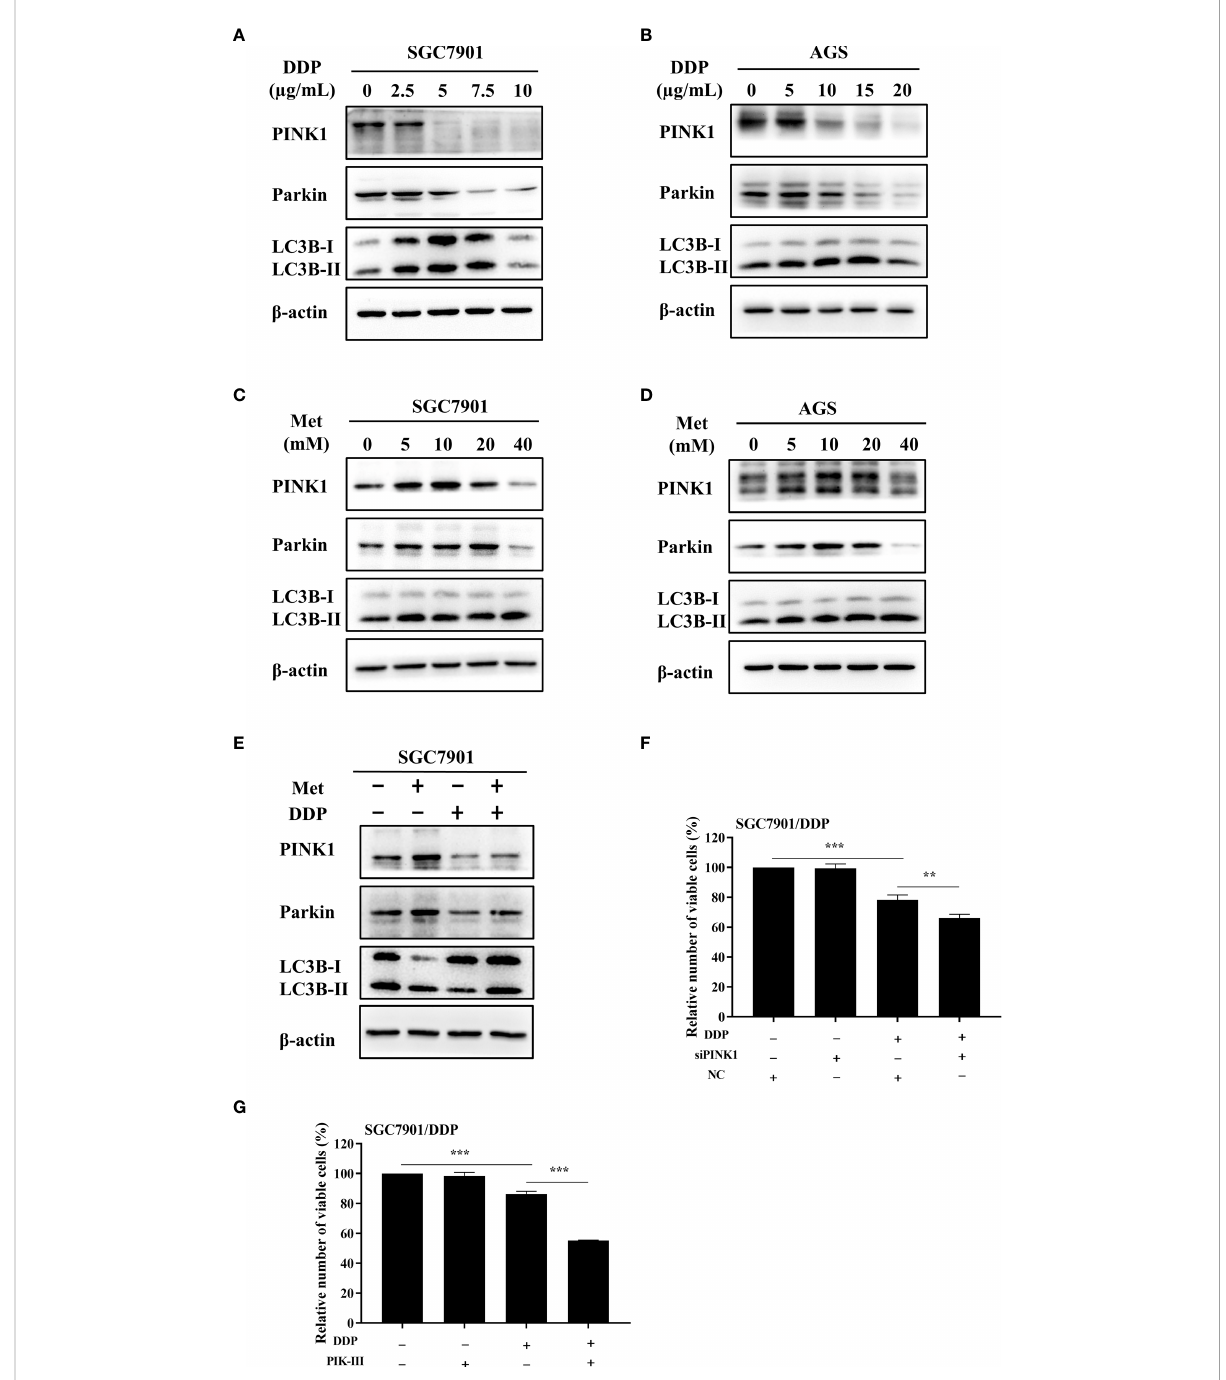
FIGURE 4 Metformin promoted cisplatin resistance via PINK1/Parkin axis in GC cells. (A, B) SGC7901 and AGS cells were treated with cisplatin and western blot was performed to determine the expression of PINK1, Parkin, LC3B. (C, D) SGC7901 and AGS cells were treated with indicated concentrations of metformin and western blot was performed to determine the expression of PINK1, Parkin, LC3B. (E) SGC7901 cells were pre- treated with 10 mM metformin for 4 h, followed by co-treating with 5 µg/mL cisplatin for 24h. The lysates were collected for western blot assay. (F) SGC7901/DDP cells were transfected with PINK1 siRNA or scramble siRNA (NC) for 24h and then treated with cisplatin. Cell proliferation was analyzed by CCK8 assay. (G) SGC7901/DDP cells were treated with cisplatin in the presence or absence of 5 µM PIK-III for 24 h. Cell proliferation was analyzed by CCK8 assay. Data were presented as the means ± SD. The experiments were repeated three times independently. ** p <0.01, *** p